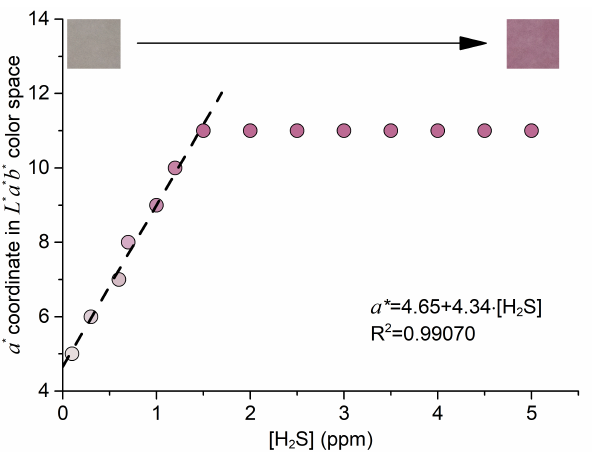
Figure 5. Colorimetric response of the paper strips mapped in the a * coordinate of the CIELAB color- space. The color of the dots corresponds to the extracted color of the sensor at each concentration. Calibration line in the low-concentration region is added as a dashed line. The linear calibration curve and coefficient of determination are also typed in the graph. Photographs of the unexposed paper (left) and color-saturated sensor (right) are included for the sake of visualization. Values were obtained as the nearest integer of the average of three independent